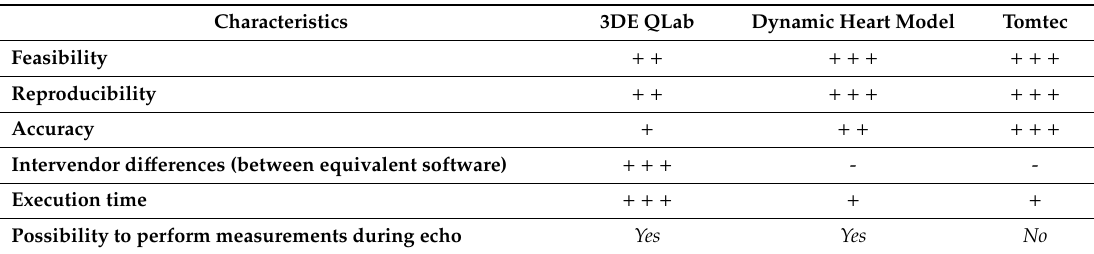
Table 6. Summary of advantages and limitations of di ff erent three-dimensional echocardiography methods for left atrium volumes